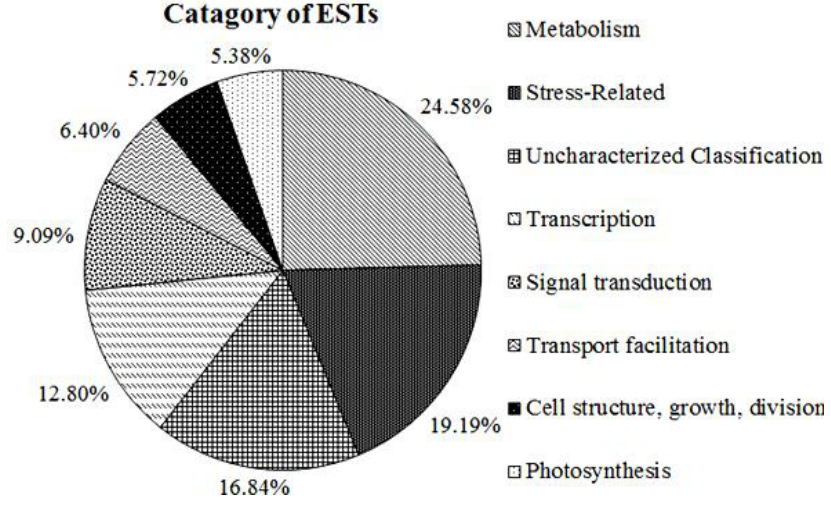
Figure 4. Ten functional categories among the 343 identified ESTs. All ESTs were assigned to functional category based not only on highest scoring BLASTX results but also on its covering extension according to the Arabidopsis MIPS functional category denomination. Percentages are with respect to the total set of ESTs with a high homology to known